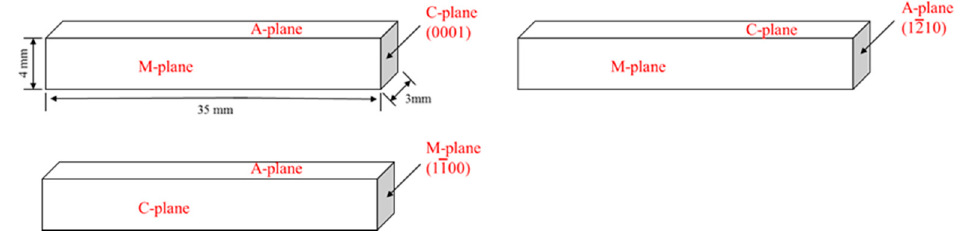
Figure 2. Three different crystal orientations of sapphire samples.